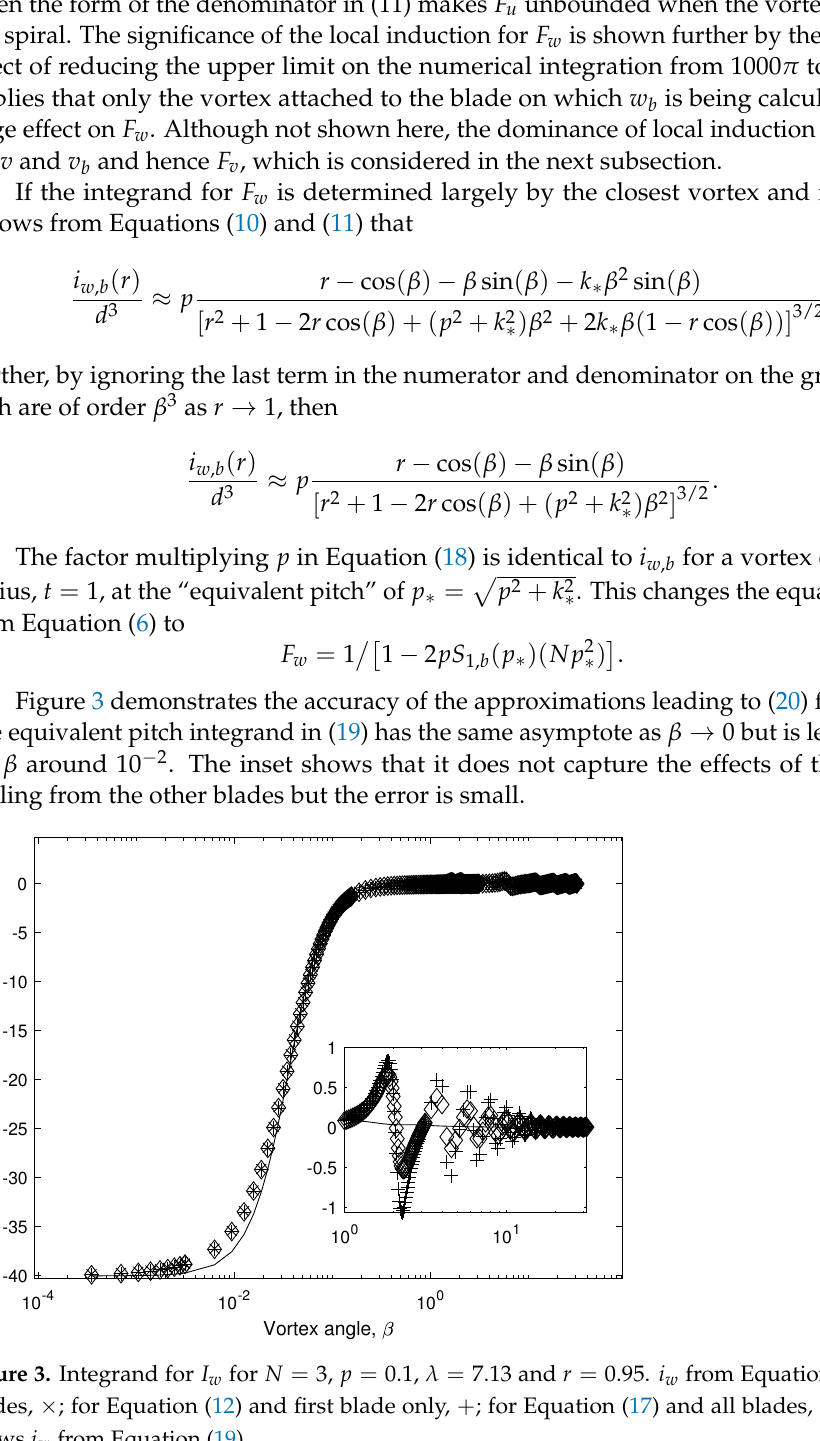
. Solid line (cid:5) . Solid line shows i w from ⋄